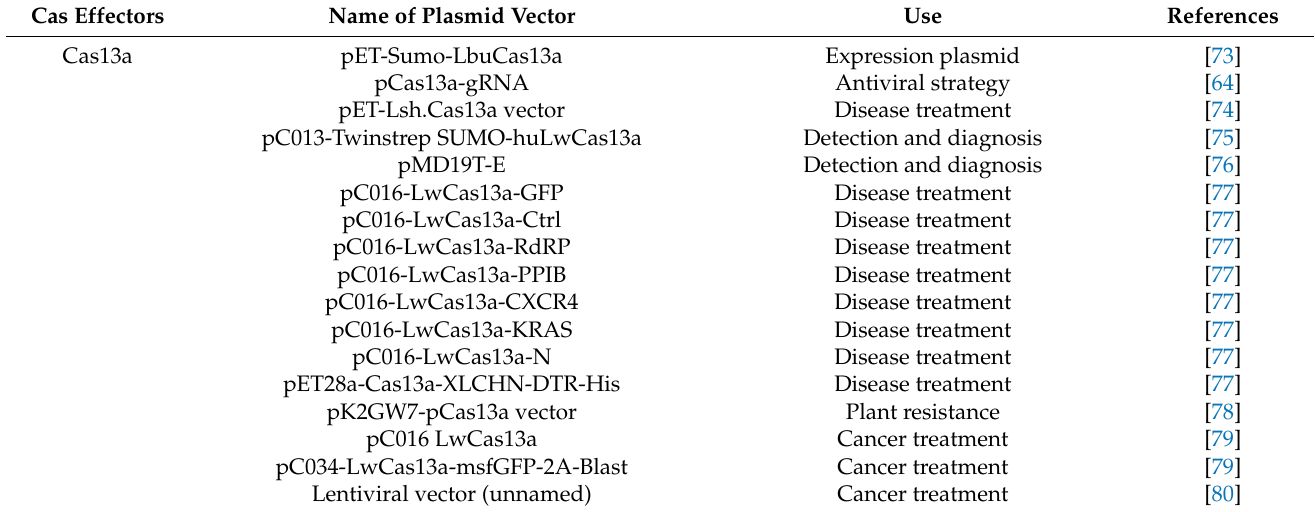
Table 4. Plasmid information of Cas13 system used in the previous